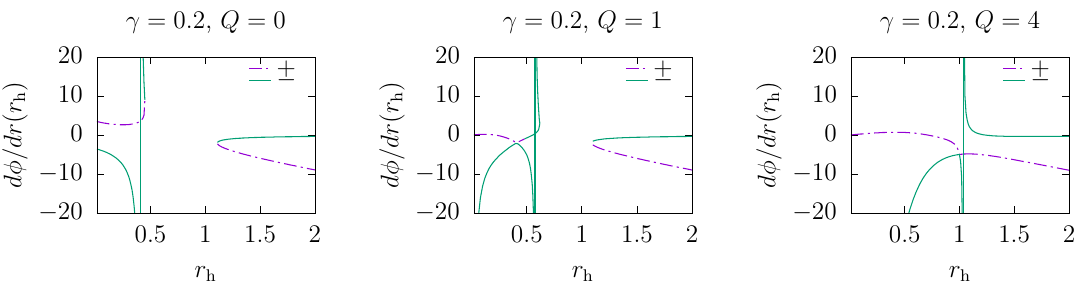
Figure 2 . We show the dependence of d(cid:30) and Q = 0 (left), Q = 1 (center) and Q = 4 (right), respectively. The + (purple, dashed) and (green, solid) indicate the sign appearing in